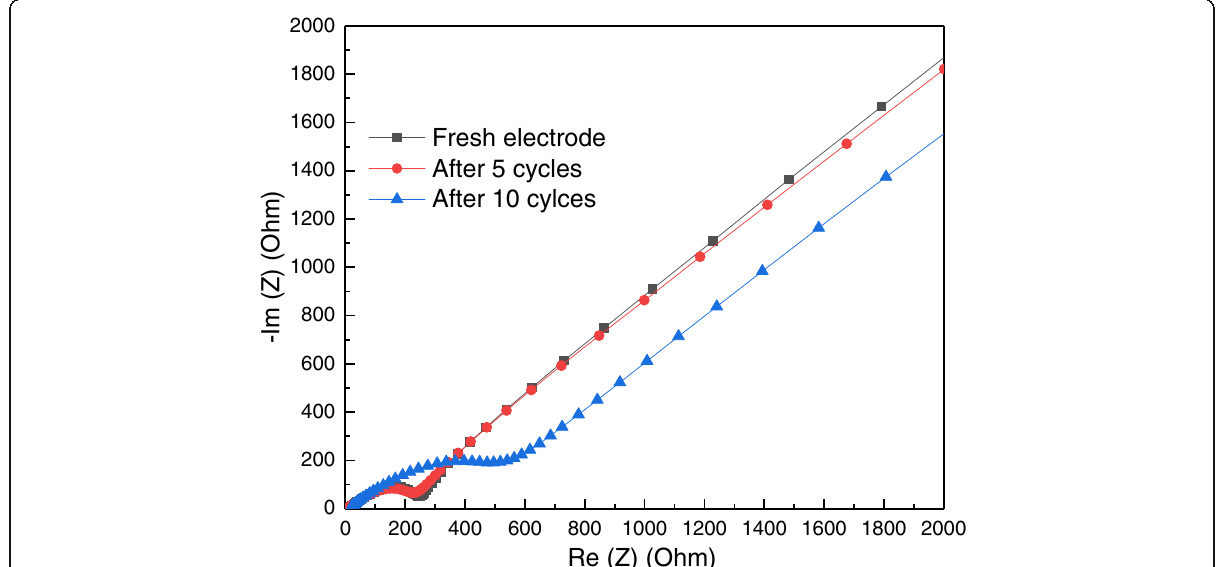
Fig. 9 EIS spectra of sea urchin-like NiCo 2 O 4 anodes after different cycling tests in a coin